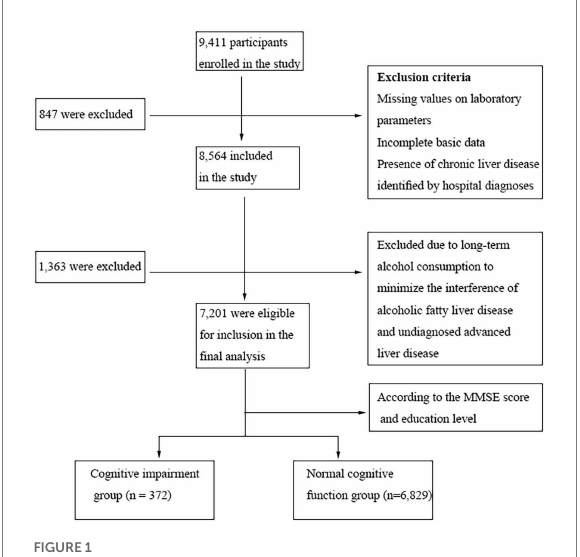
FIGURE 1 Flow diagram of this cross-sectional